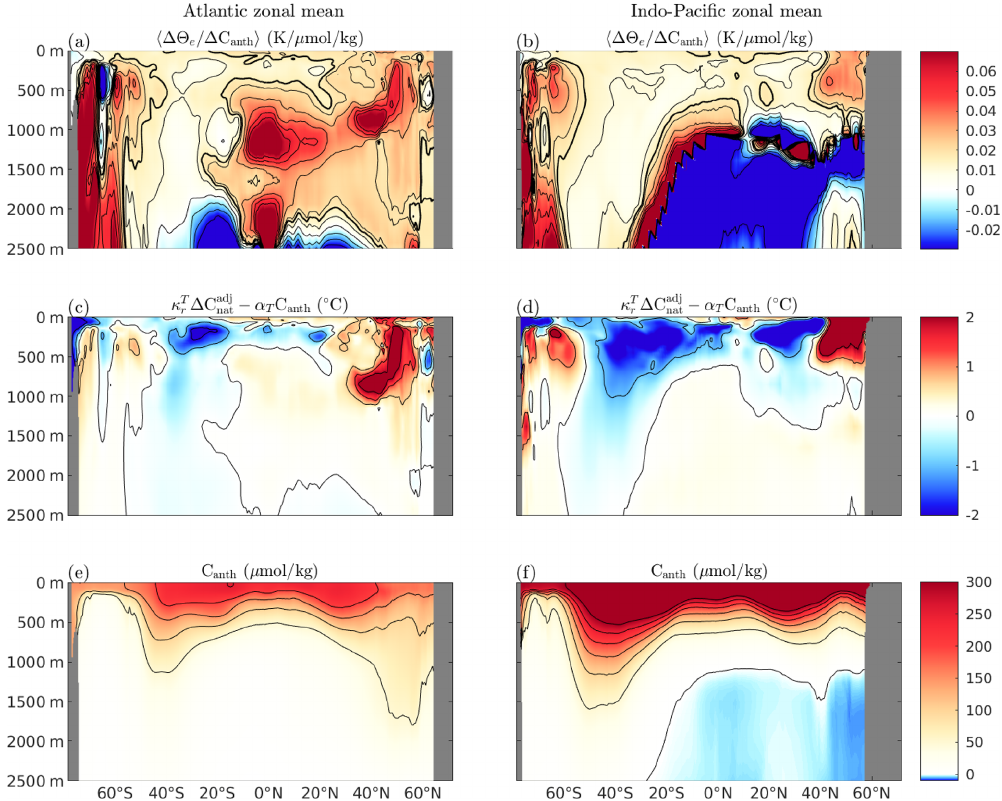
Figure 3. Atlantic and Indo-Pacific zonal mean ratio of excess temperature to C anth accumulation, calculated as the 2090s decadal, zonal mean temperature divided by 2090s decadal, zonal mean C anth (panels a and b ). Panels (c) and (d) show the difference between our excess temperature estimate and the excess temperature estimate produced using the method of Bronselaer and Zanna (2020), and panels (e) and (f) show the zonal mean C anth accumulation calculated as the 2090s decadal mean. The thick black contour in panels (a) and (b) indicates the global mean value of α T of 0.016K(µmolkg − 1 ) − 1 , and the thin contours are indicated on the colour